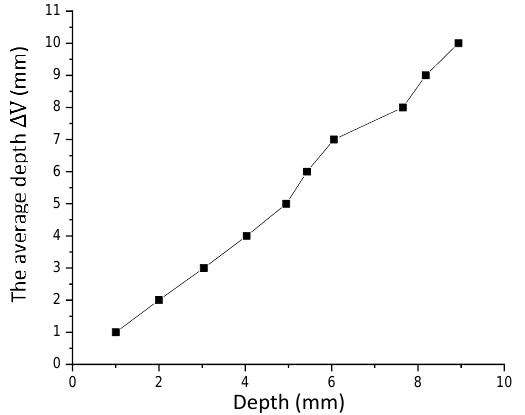
FIGURE 16 The average depth as a function of the crack